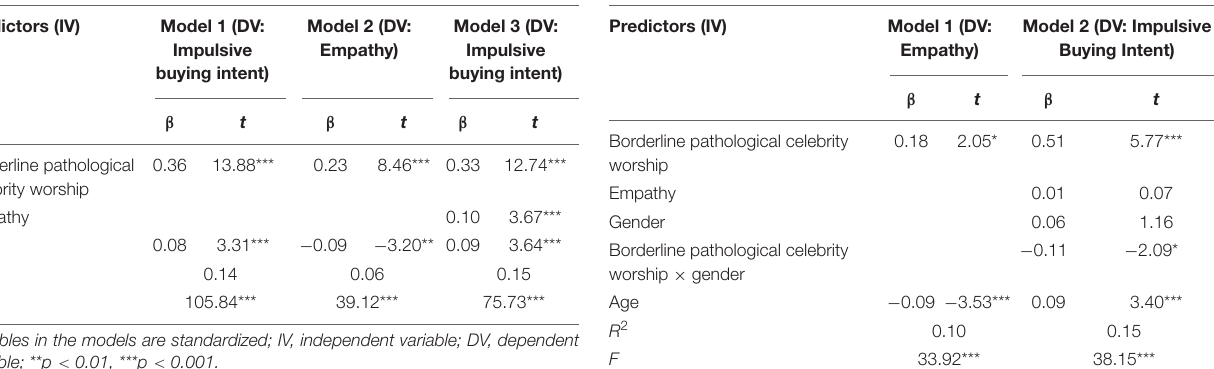
TABLE 2 | Testing the mediation effect of empathy. TABLE 3 | Testing the moderated mediation model.